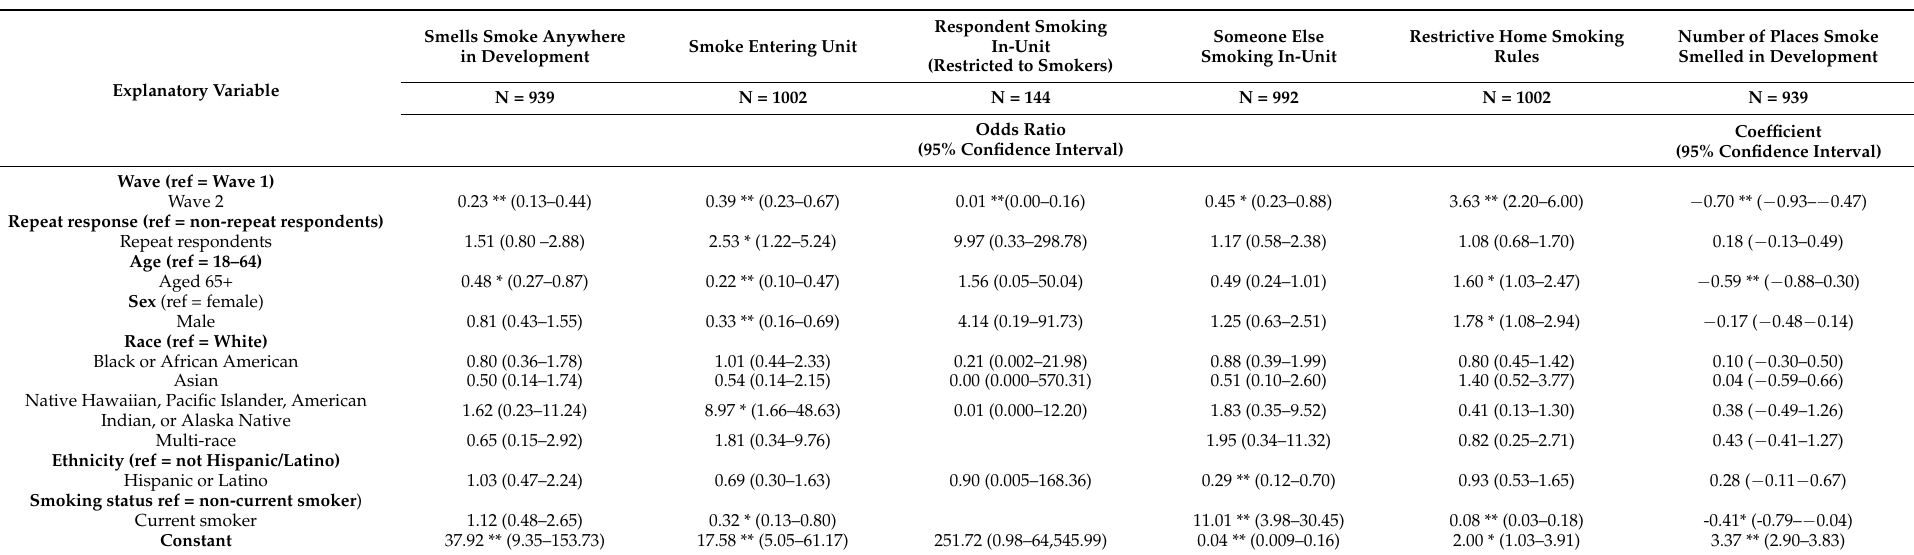
Table 4. Multivariate regression results for SHS exposure, smoke-free policy noncompliance, and presence of restrictive home smoking